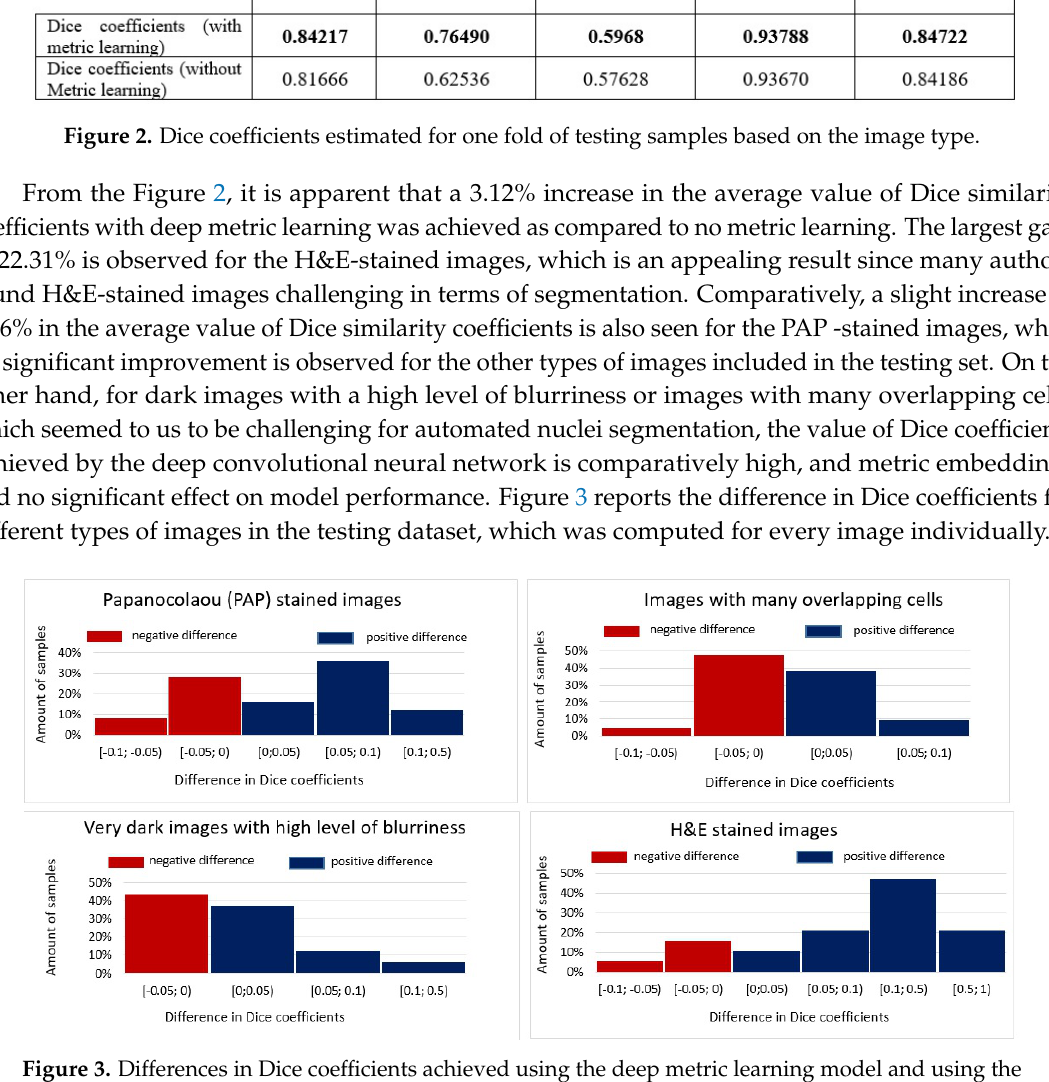
Figure 3. Differences in Dice coefficients achieved using the deep metric learning model and using the deep network model without metric learning for different types of images in the testing